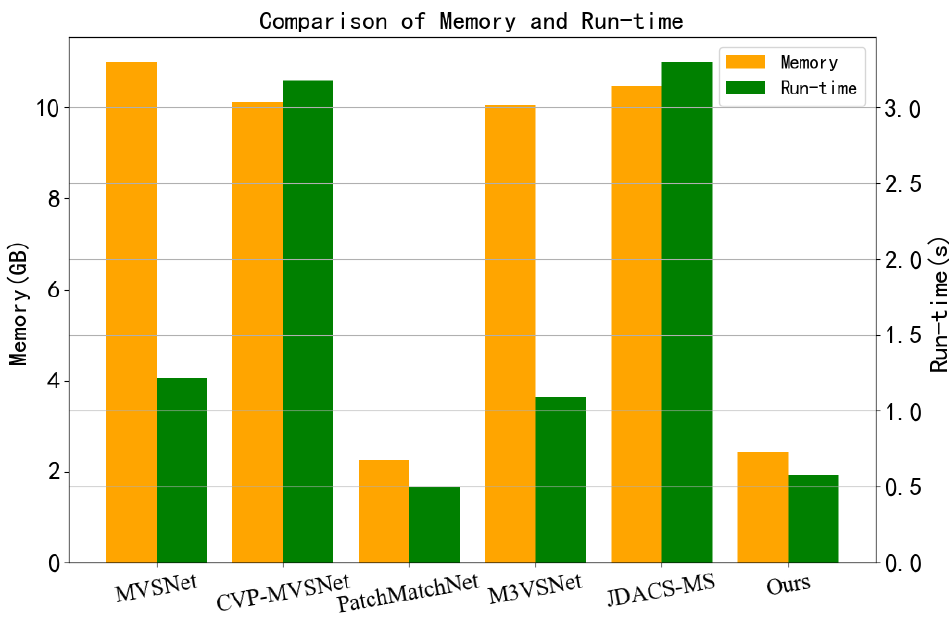
Figure 9. Comparison of memory usage and time consumption.